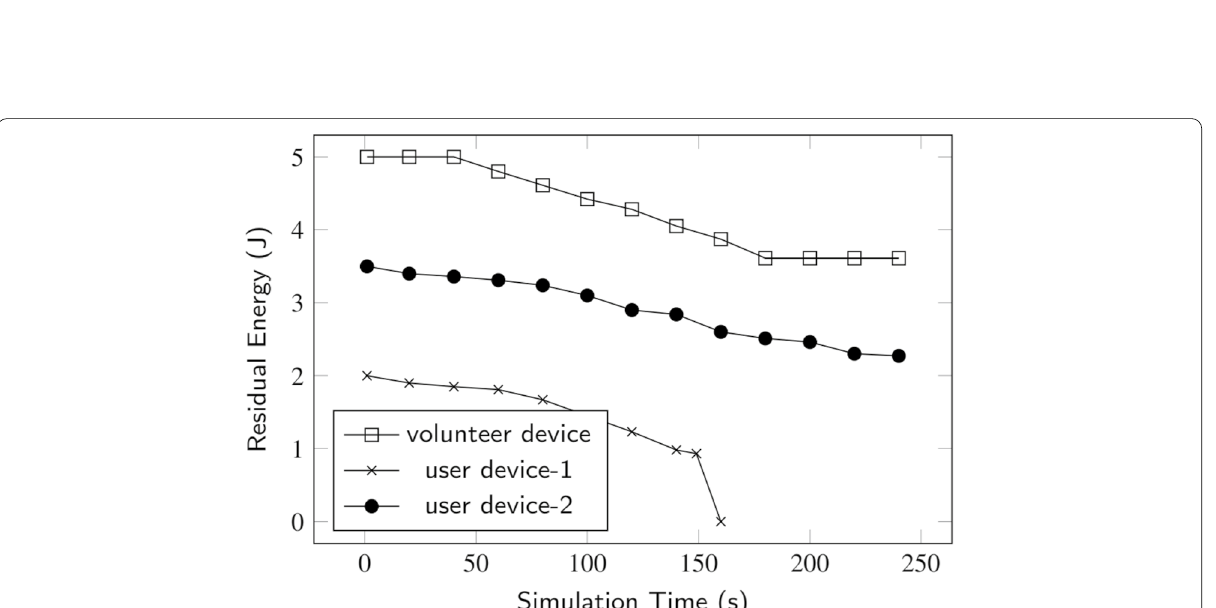
Fig. 7 Residual Energy of the IIoT devices in user mode where devices offload workloads, and volunteer mode when devices execute received